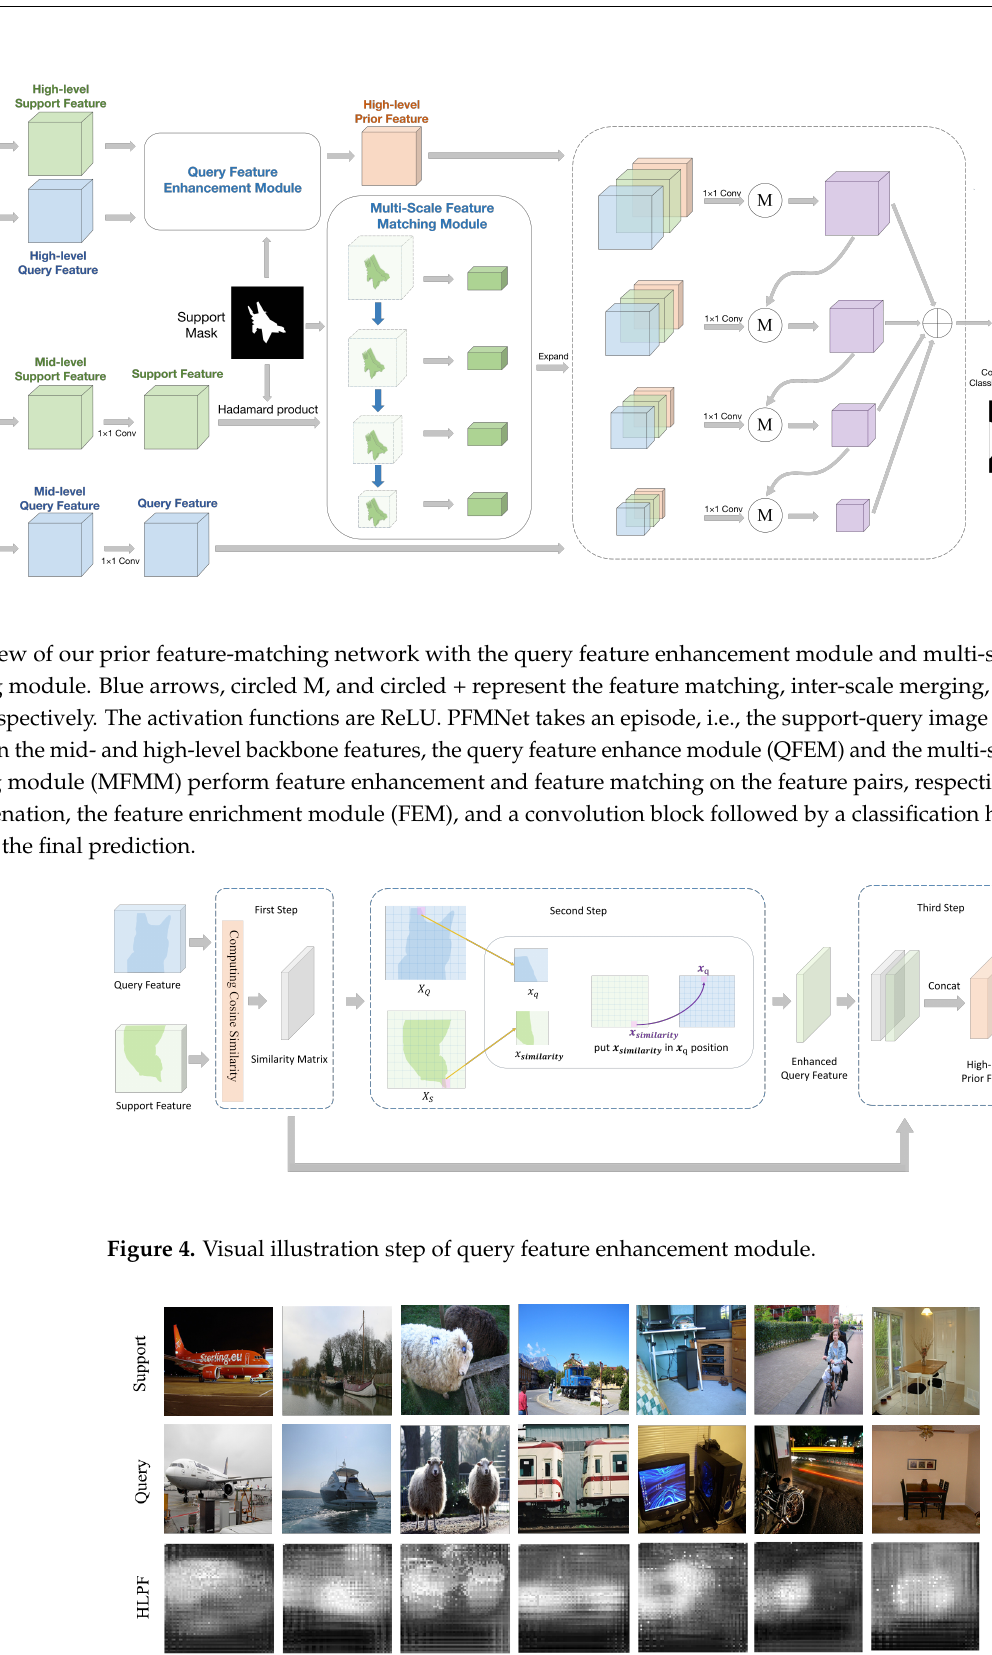
Figure 5. Visualization of the QFEM output. This output is a High-Level Prior Feature and is noted as